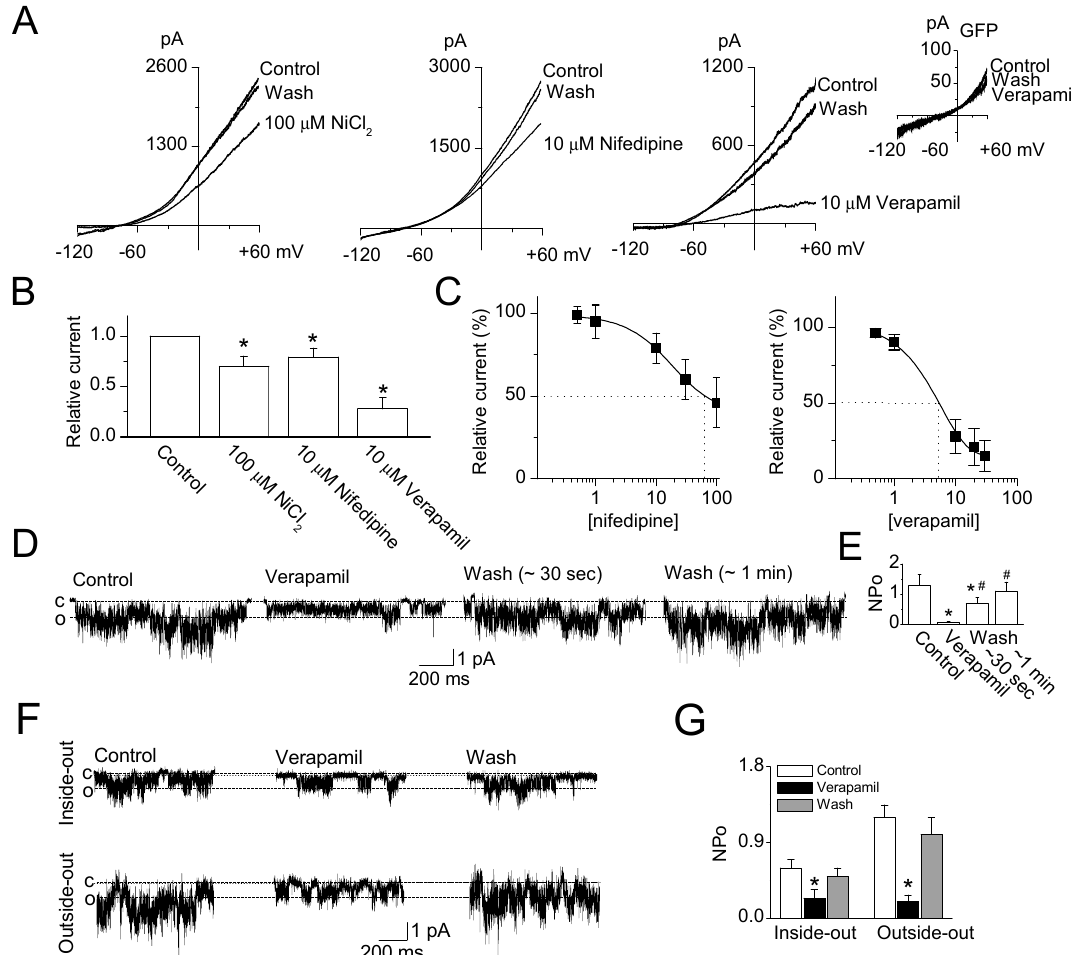
Figure 1. Effect of Ca 2+ channel blockers on TRESK channels overexpressed in HEK-293 cells ( A ) TRESK whole-cell currents were inhibited by NiCl 2 (100 µ M), nifedipine (10 µ M), and verapamil (10 µ M). The currents were recorded from HEK-293 cells transfected with mTRESK. GFP represents the currents recorded from only green fluorescent protein (GFP)-transfected cells; ( B ) Summary of the effects of NiCl 2 , nifedipine, and verapamil on the TRESK currents. The current levels at +60 mV were determined and analyzed. Data represent the mean ± SD of three independent transfections ( n = 10). * p < 0.05 compared with the control currents; ( C ) Inhibition curve of nifedipine and verapamil. IC 50 is the concentration that reduces TRESK currents by 50%. Data represent the mean ± SD of three independent transfections ( n = 5); ( D ) Verapamil-induced inhibition of TRESK single-channel currents. Single-channel openings were recorded at − 60 mV in symmetrical 150 mM K + solution. Verapamil dissolved in DMSO was applied to the cells under cell-attached patches. The data was taken 1 min after each treatment; ( E ) Summary of the effect of verapamil on TRESK channels in the cell-attached modes. Data represent the mean ± SD of three independent transfections ( n = 6). * p < 0.05 compared with the control. # p < 0.05 compared with the verapamil treatment; ( F ) Effect of verapamil on TRESK activity in inside-out and outside-out patches at − 60 mV in symmetrical 150 mM K + solution. An outside-out patch was made from a whole-cell patch, which was obtained from cell-attached patch by applying gentle suction. An inside-out patch was directly obtained from a cell-attached patch without process making whole-cell patch; and ( G ) Summary of the effect of verapamil on TRESK channels in the excised patch modes. Data represent the mean ± SD of three independent transfections ( n = 5). * p < 0.05 compared with the control. C and O represent closed and open states, respectively.